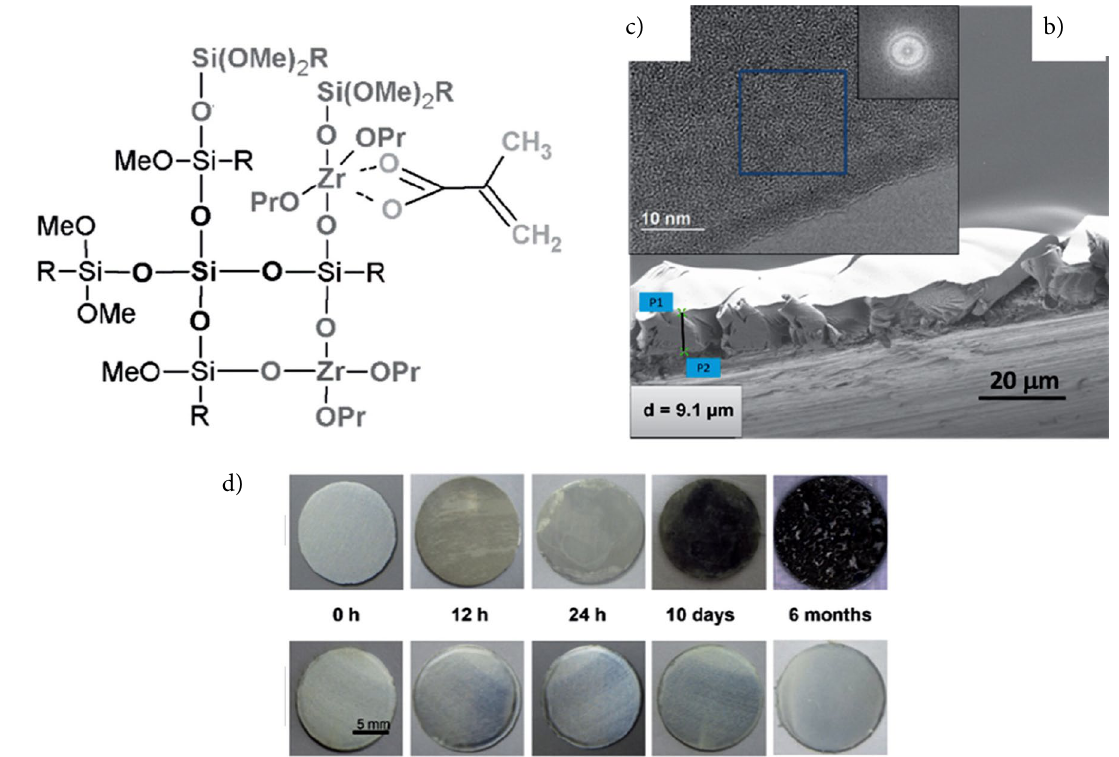
Figure 12. (a) Schematic presentation of the hybrid TMZ network formed by a sol-gel process using TEOS (tetraethyl orthosilicate), MAPTMS (3-methacryloxypropyl trimethoxysilane), ZTP (zirconium(IV) propoxide) and MMA (methacrylic acid). ( Reprinted from the publication by P. Rodič, J. Iskra, I. Milošev, J. Non-Cryst. Solids, 2014 , 396 − 397, 25 − 35 with permission from Elsevier. 78 ) (b) SEM image of cross-section of TMZ coating showing homogeneous and dense structure. Coating thickness is cca. 9 µm thick. ( Reprinted from the publication by P. Rodič, A. Mertelj, M.